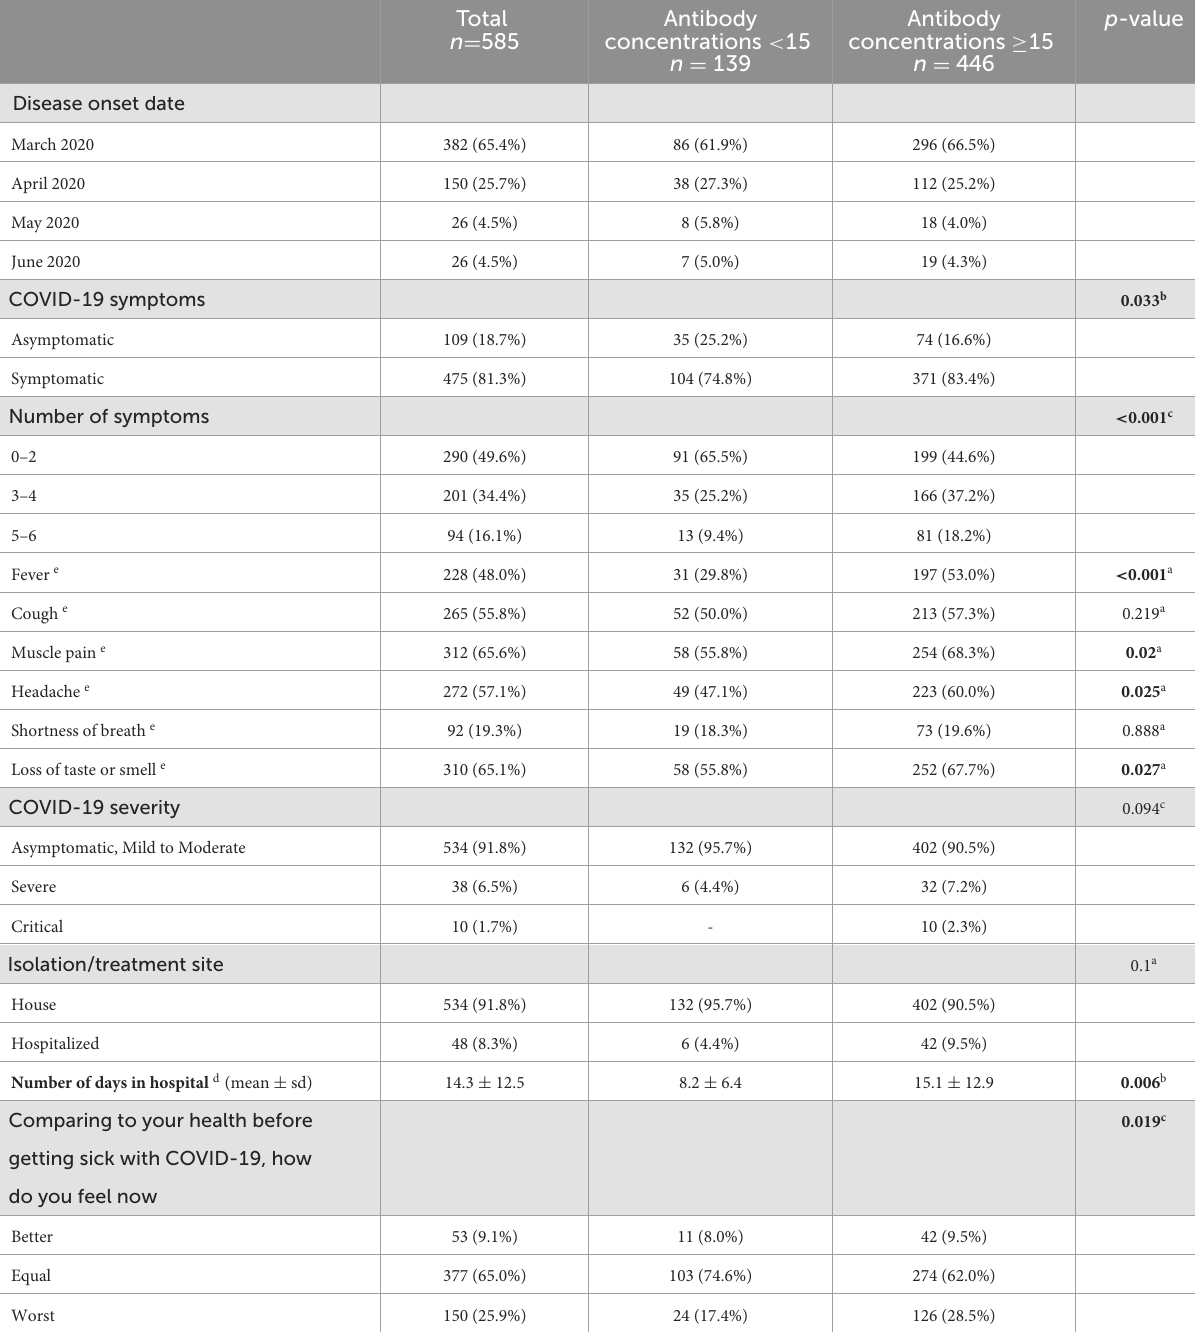
TABLE 3 Specific characteristics related to COVID-19, by antibody